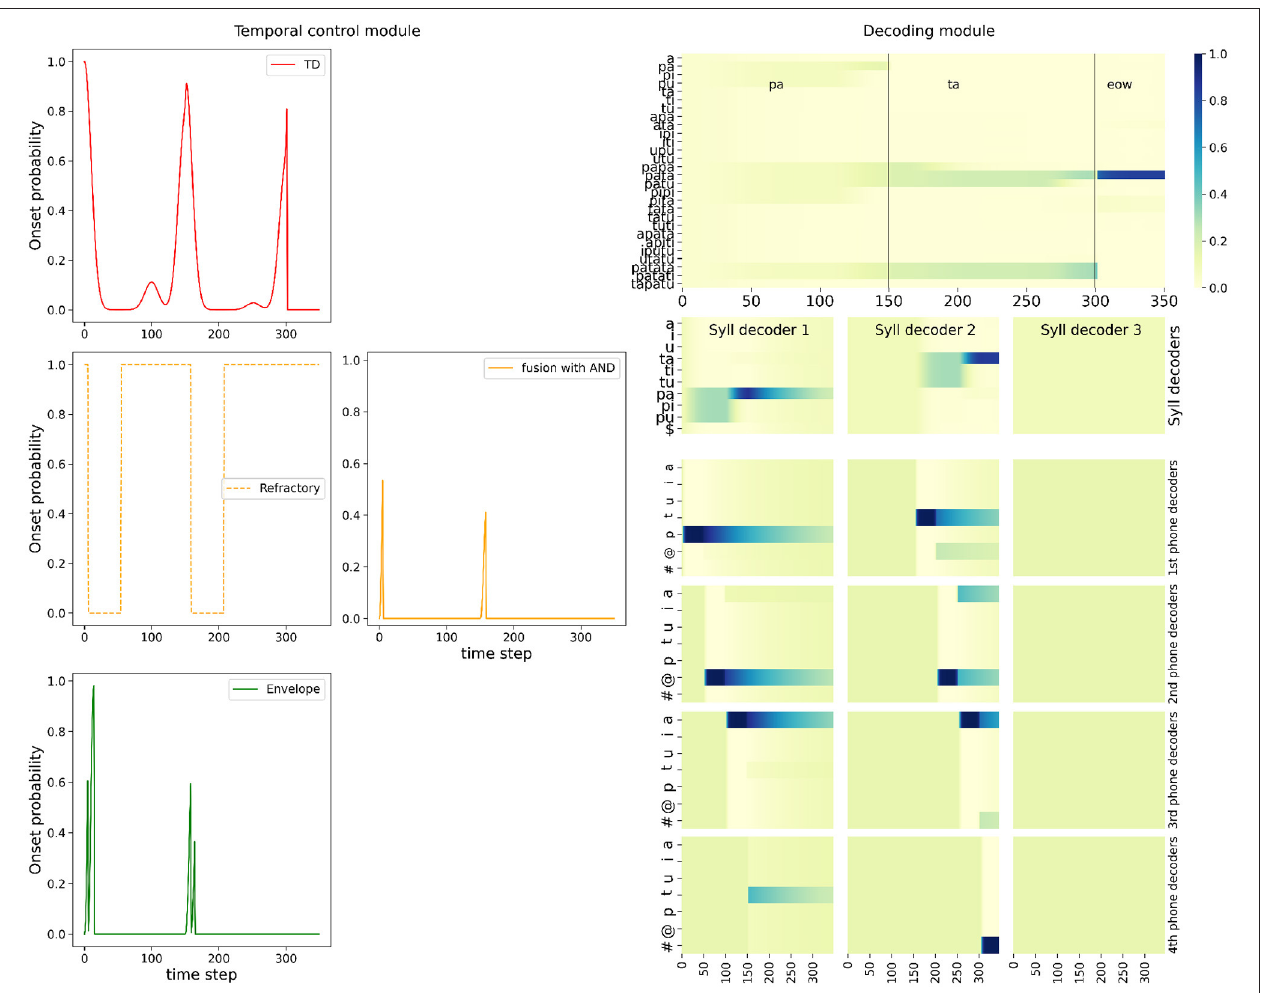
FIGURE 6 | Example of simulation of the full model with the AND fusion in the nominal condition, on input word “pata.” Plots are organized to roughly map with corresponding positions in the model schema, see Figure 1 . ( Left , “Temporal control module” panel) Plot of the onset detection probabilities computed in the model ( y -axis) as a function of simulated time ( x -axis). Left column: In red, top-down onset prediction, in dashed orange, the probability of an onset being outside a refractory period, in green, onset probability based on sensory processing of stimulus loudness. (Middle) : in orange, the onset probability of the AND fusion model ( Right , “Decoding module” panel) Top plot shows the probability (color coded, see the color bar on the right) over words ( y -axis) as a function of time ( x -axis). The vertical black bars, and annotations at the top of the plot recall the stimulus structure; in this example, the stimulus is the word “pata,” with the acoustic signal of the first syllable during the first 150 iterations, the one of the second syllable during the next 150 iterations, followed by silence. Second row: plots of the probabilities (color coded) over syllables ( y -axis), as a function of time ( x -axis) during the activation of the corresponding syllable decoder. Bottom four rows: plots of the probabilities (color coded) over phones ( y -axis), as a function of time ( x -axis). Plots for phone decoders are sorted vertically, with the first phone above and the fourth at the